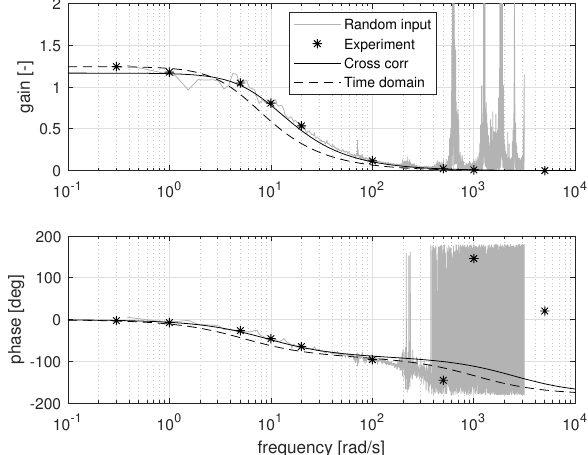
Figure 15. Bode plot of δω ∗